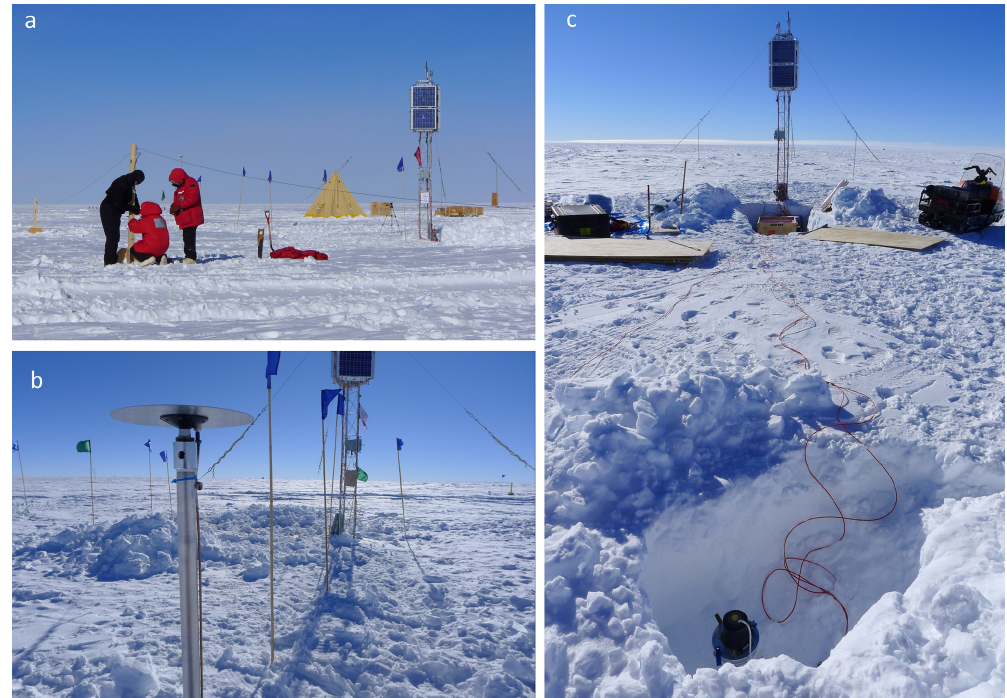
Figure 2. (a) shows HF radio antenna being installed next to system tower. (b) shows the GPS antenna for the dual-frequency CASES receiver mounted on a pole near the tower. (c) shows a view of the installation from the location of the fluxgate sensor pit. At the base of the tower is a pit containing the super-insulated electronics box and the battery box. The tower holds the photo voltaic (PV) panel array as well as antenna for the Iridium